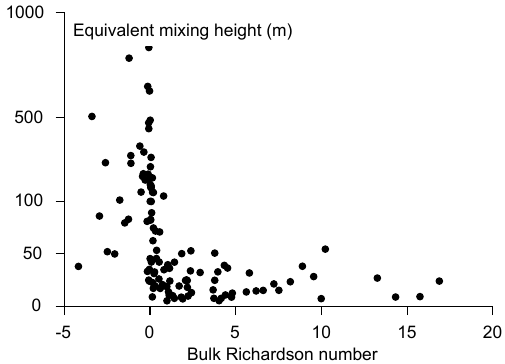
Fig. 8. Hourly measurements of calibrated equivalent mixing height, h e , versus bulk Richardson number, Ri b . The y-axis is mag- nified 5 × below 100m, and 163 data points are